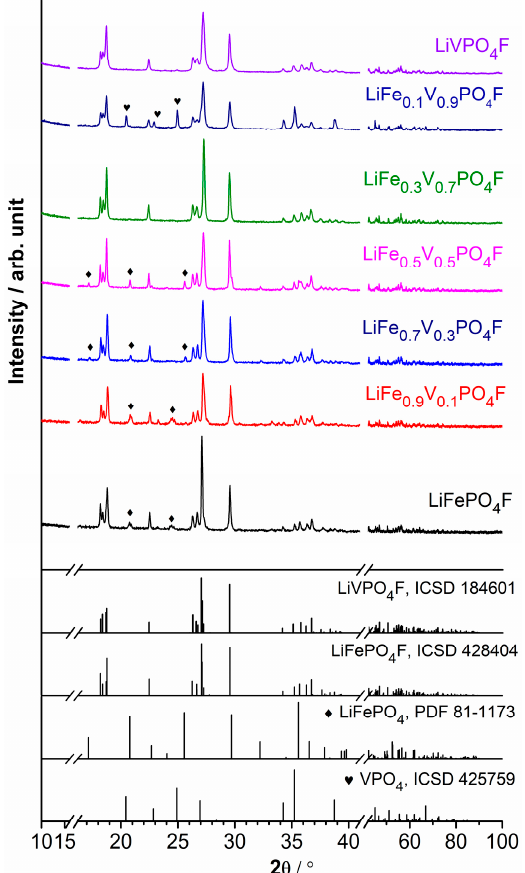
Figure 1. XRD full patterns of LiFe 1 − x V x PO 4 F (0 ≤ x ≤ 1) powders.